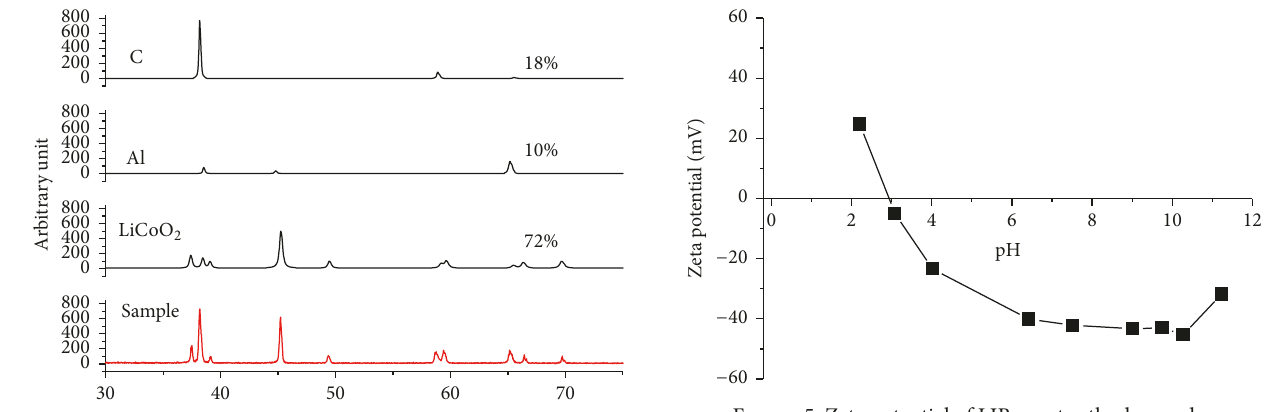
Figure 5: Zeta potential of LIB spent cathode